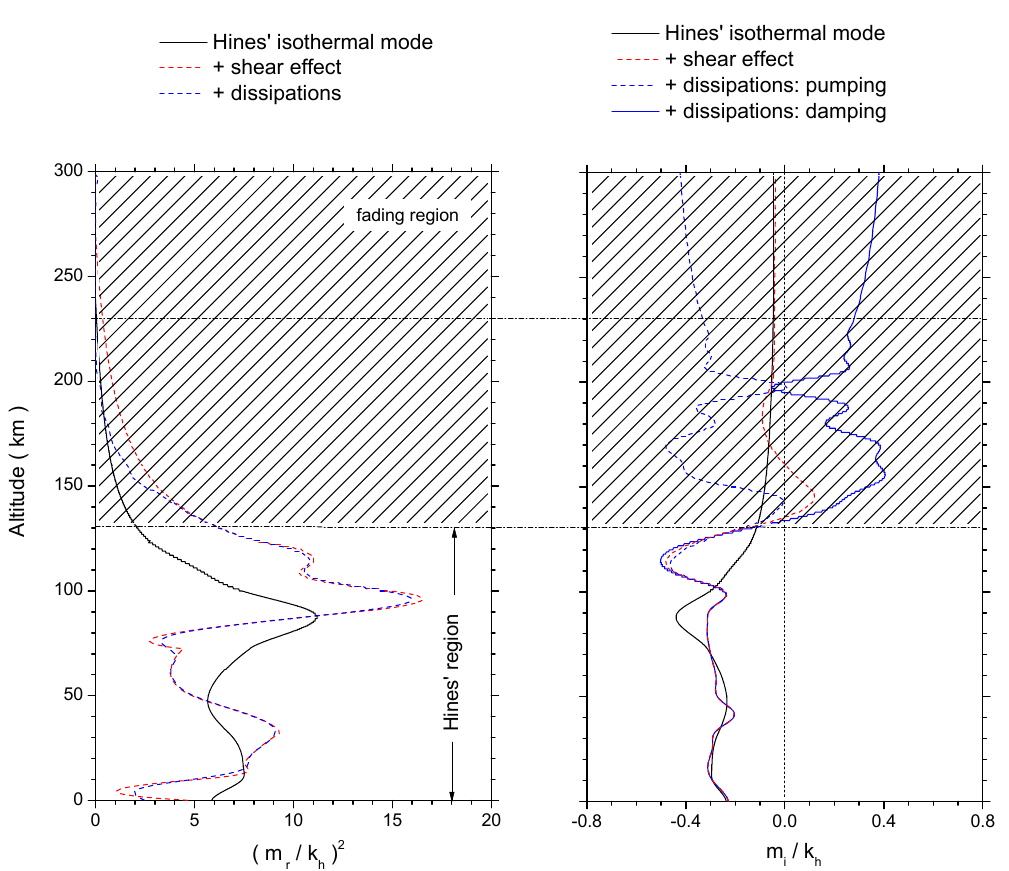
Figure 4. Fading of Hines’ wave modes due to viscosity. LHS panel: squared real part of the dimension-free vertical wavenumber, ( m r / k h ) 2 ; RHS: imaginary part of the dimension-free vertical wavenumber, m i / k h . Fading regions of Hines’ wave modes are